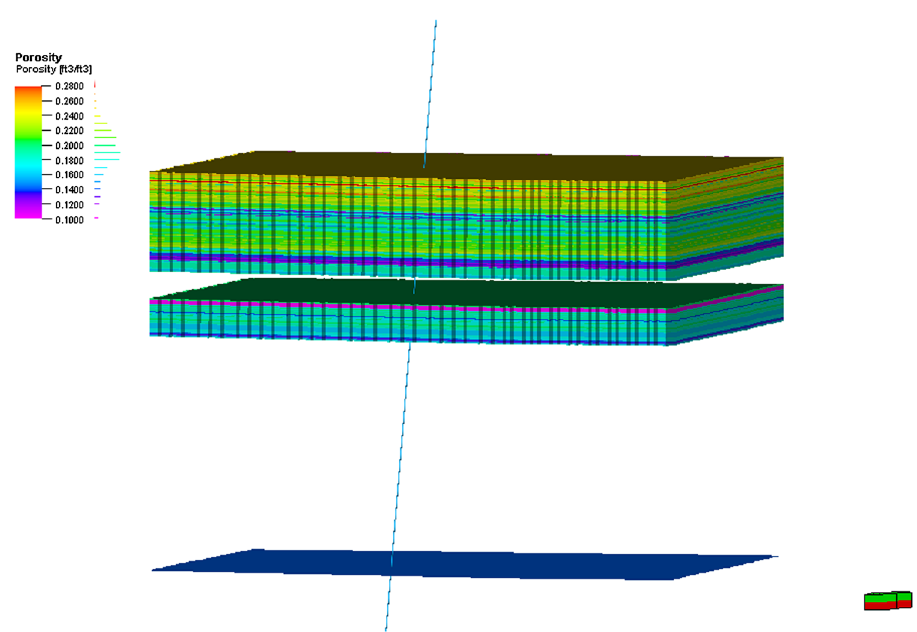
Fig. 19 Single well model showing porosity